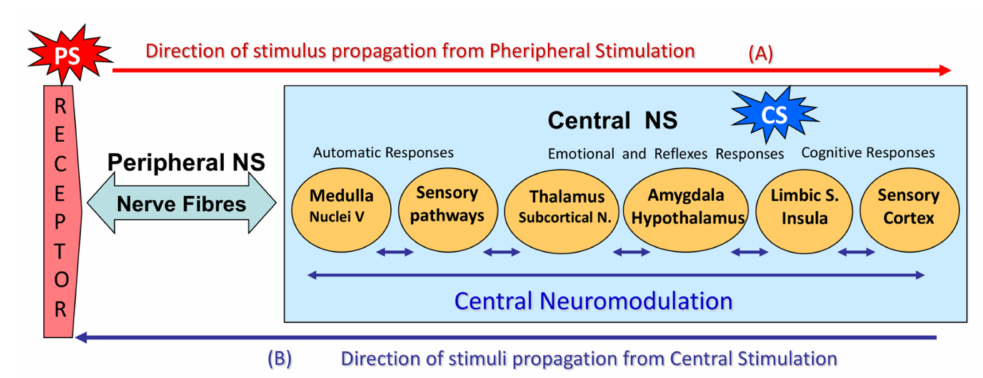
Figure 1. Diagram showing the physiology of craniofacial sensitivity, sensory perception of pain, and pain